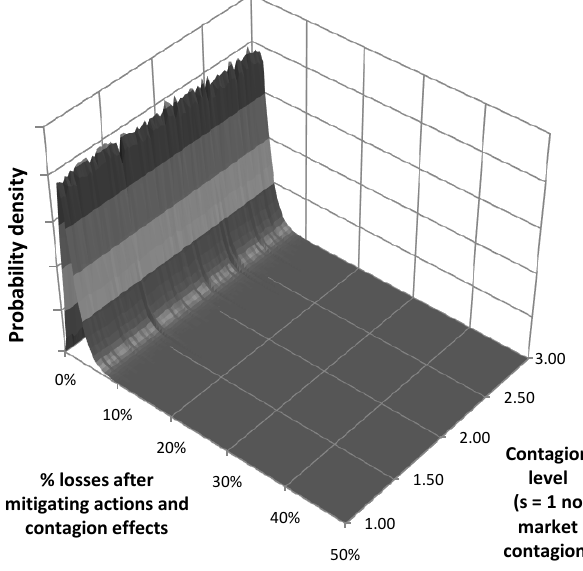
FIGURE 19: UK 2005, buffer restoration model illustrating contagion levels Source: Authors’